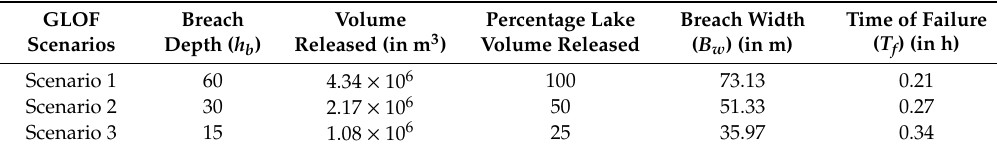
Table 1. Breach parameters for scenario modeling calculated based on Froehlich (1995).